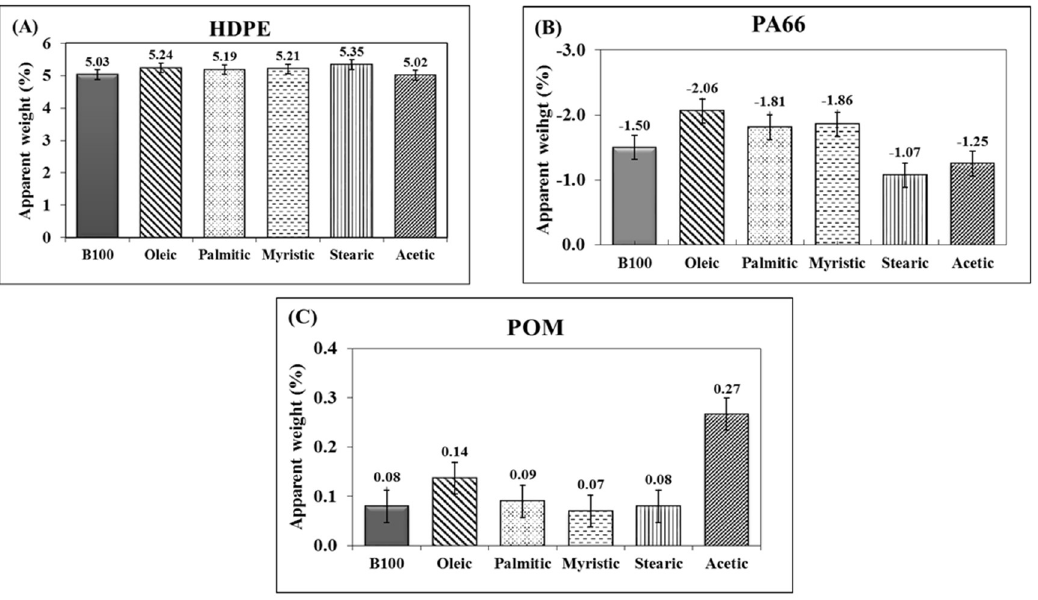
Figure 2. Variation of apparent weight of polymeric materials after immersion in pure palm biodiesel (B100) and B100–acid blends. ( A ) HDPE, ( B ) PA66 and ( C) POM.